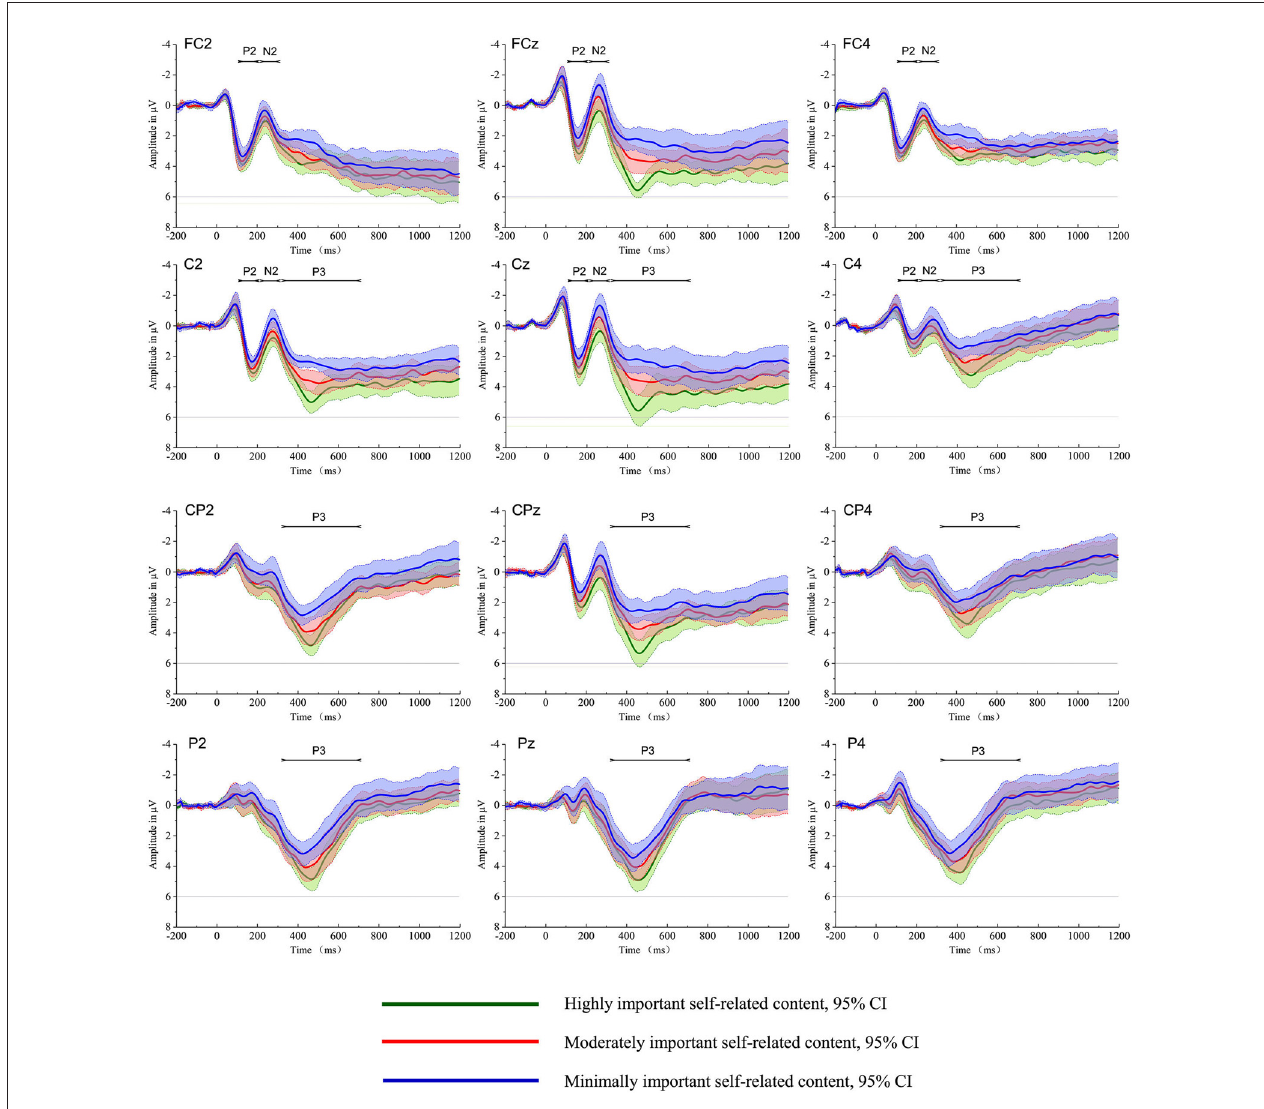
FIGURE 1 | The grand average of the event-related potentials (ERPs) evoked by the highly important, moderately important, and minimally important self-related content conditions at electrodes FC2, FC4, FCz, C2, C4, Cz, Cp2, CP4, CPz, P2, P4 and Pz. The shaded area indicates the 95% confidence interval of the ERPs.